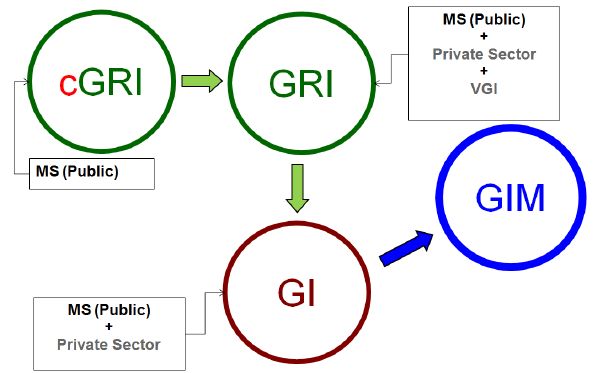
Figure 1: Flow of geographic information as envisaged by UN-GGIM